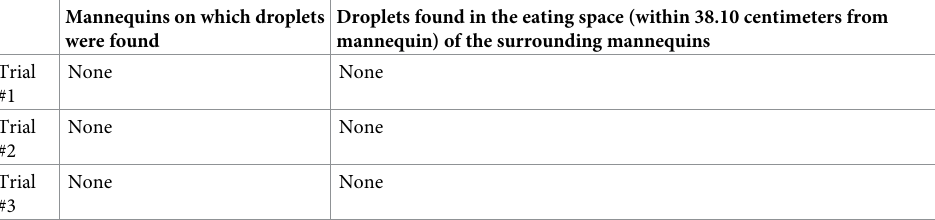
Table 5. (Experiment 5): Droplet spread with extended barrier use. Mannequins on which droplets were